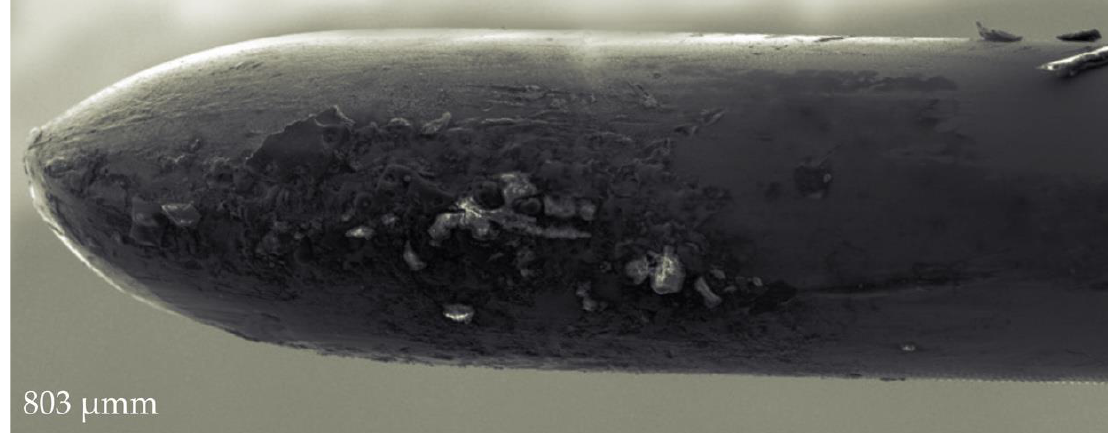
Figure 7. Wire breakage and the “neck” diameter reduced several fold due to melting.